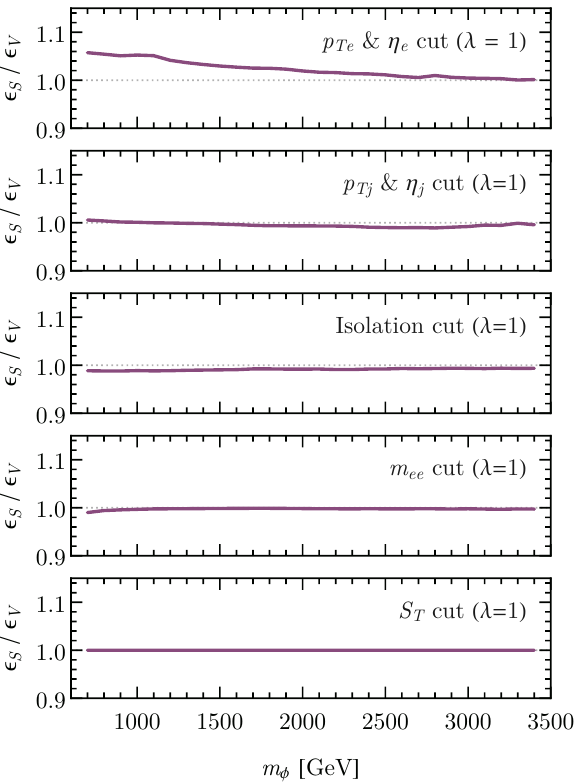
Figure 3. Ratios of relative signal e(cid:14)ciencies for scalar and vector leptoquarks as functions of leptoquark mass m (cid:30) and for (cid:12)xed coupling (cid:21) = 1. We take (cid:30) eu as an example and investigate the process pp e + e (cid:0) j . The panels show the relative e(cid:14)ciencies of a series of selection cuts from the ! CMS search [17]. See text for more